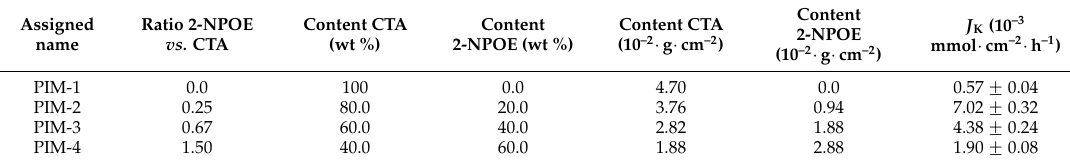
Table 3. Effect of the content of plasticizer in PIM. Fluxes monitored in the receiving